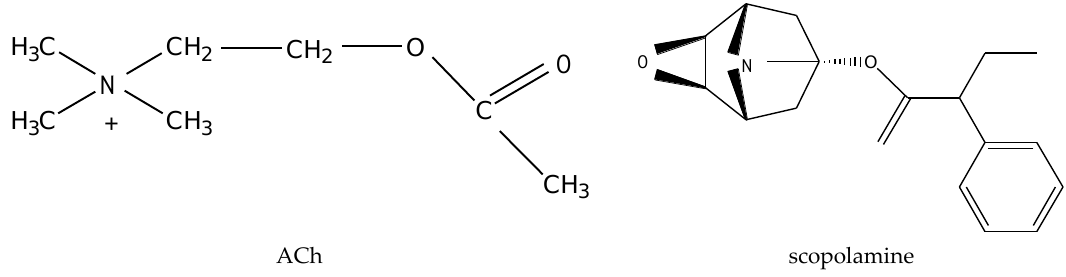
Figure 4. Structure of acetylcholine (Ach) and scopolamine.